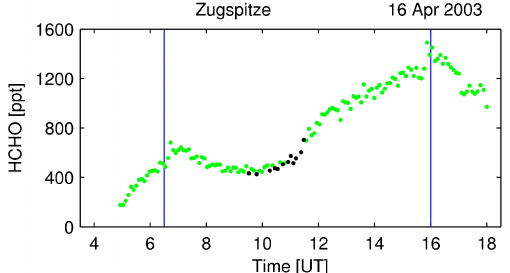
Figure 12. Diurnal evolution of X HCHO on 16 April 2003 at Zugspitze without (green) and with (black) applying the filter crite- ria as described in Sect. 6.2. The two blue lines indicate SZA = 70 ◦ on that